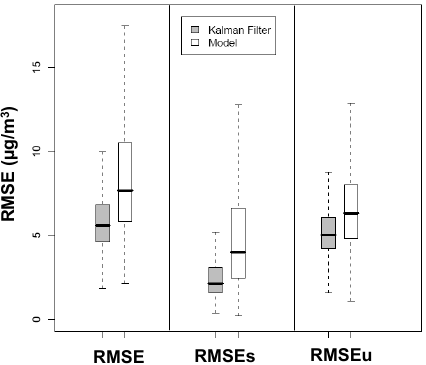
Fig. 10. Box plots of RMSE and decomposed RMSE (systematic, RMSEs; unsystematic, RMSEu) values of the daily mean PM 2.5 concentrations (µg/m 3 ) for the raw model forecasts and KF bias-adjusted forecasts.